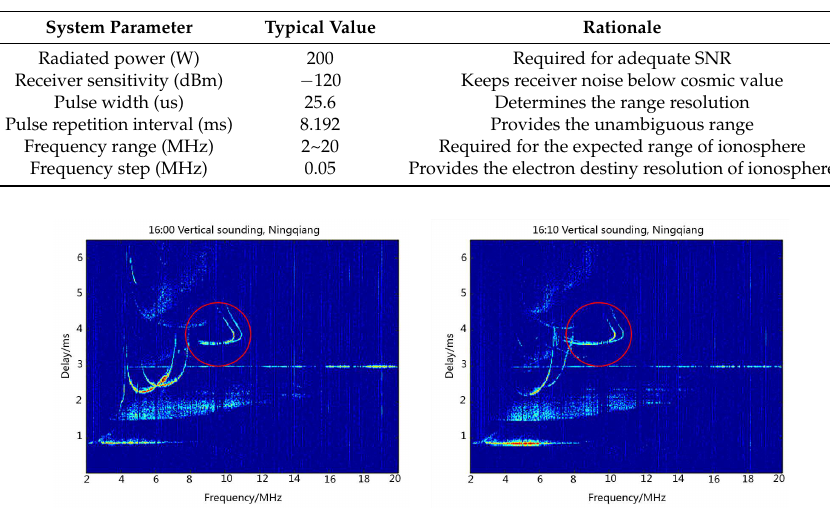
Table 3. Parameters of the emission waveform.